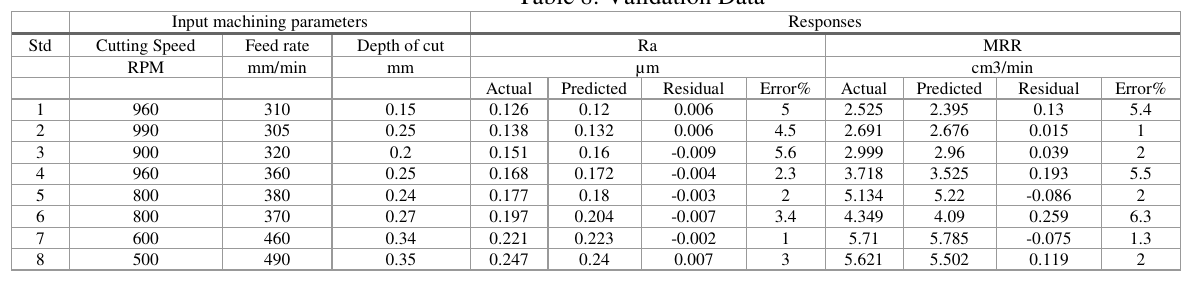
Table 9: Optimal Response Values with Optimal Process Parameters Sr.